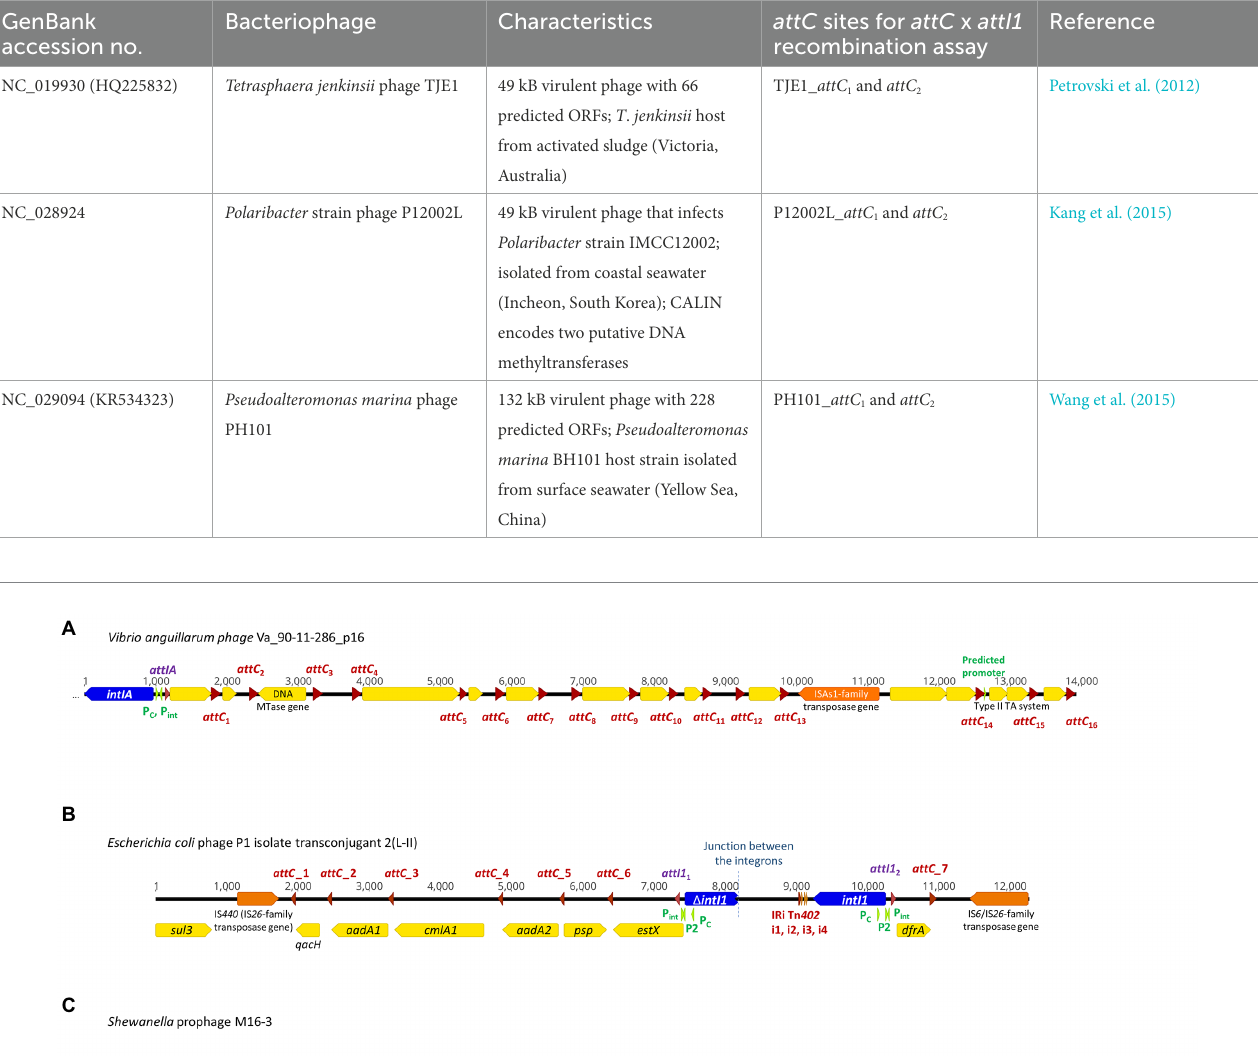
TABLE 2 Experimentally isolated and characterized virulent phages that contain CALINs with predicted gene cassettes and attC sites. GenBank accession no.